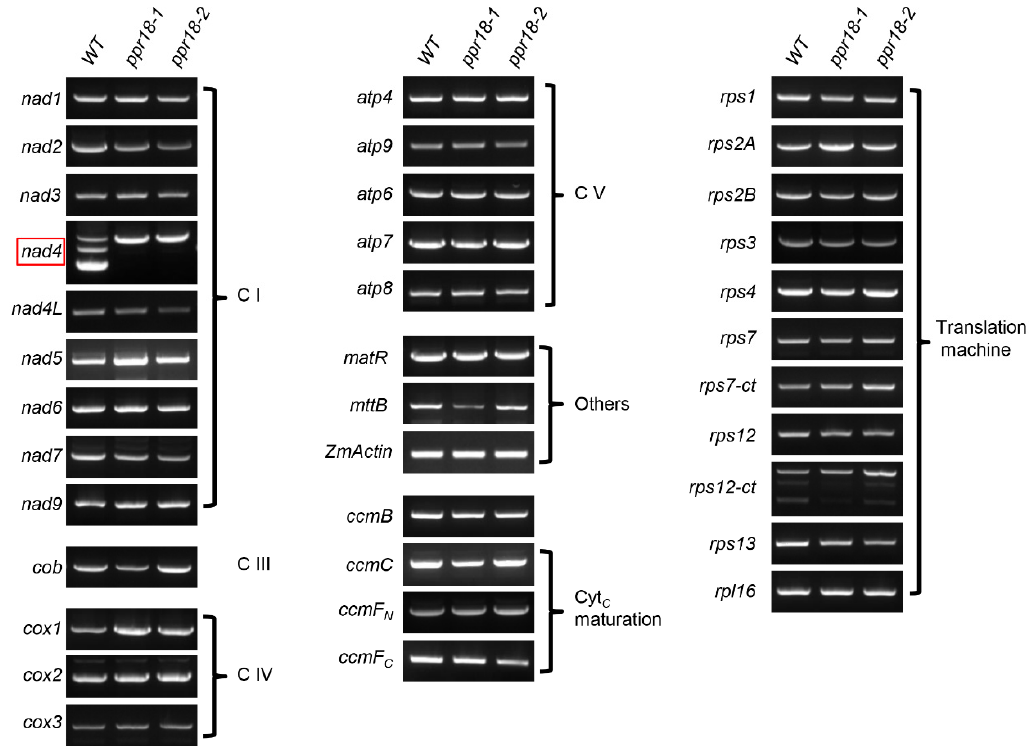
Figure 5. The ppr18 mutants only affect the expression of mitochondrial nad4 mature transcript. The transcript levels of 35 mitochondrion-encoded genes in ppr18-1 and ppr18-2 mutant kernels. The RNA was isolated from the same ear segregating for WT and ppr18 mutants at 13 days after pollination (DAP). The expression levels were normalized to ZmActin (GRMZM2G126010). The absence of nad4 transcripts occurs in both ppr18 alleles (red box indicated). C I: Complex I, C II: Complex II, C III: Complex III, C IV: Complex IV, C V: Complex V.